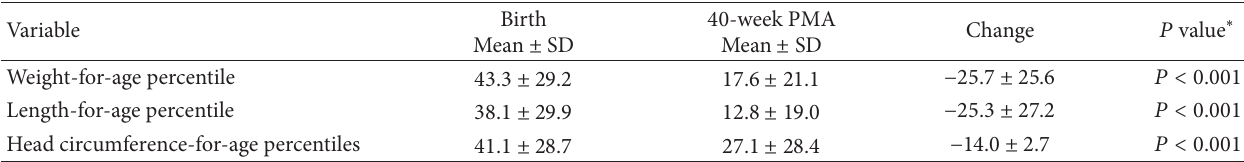
Table 2: Change in anthropometric percentiles from birth to 40-week PMA among NICU infants with intestinal failure or feeding intolerance ( 𝑁 = 164 ).